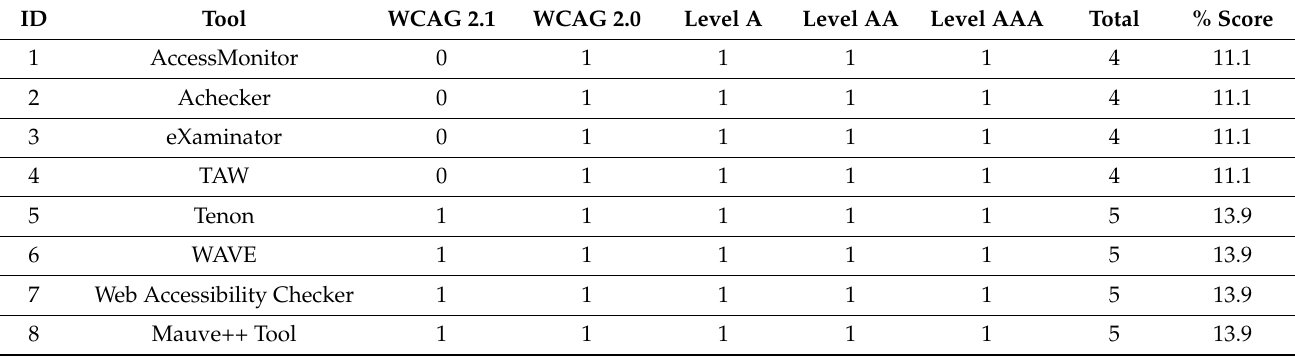
Table 1. Selection of the automatic review tool.